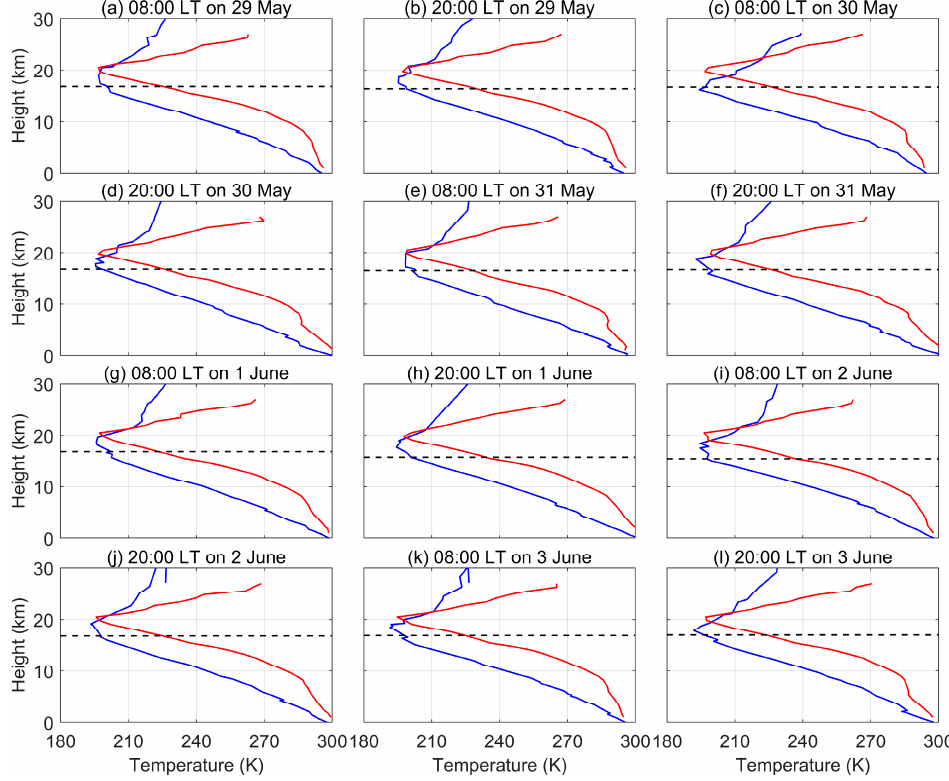
Figure 5. Temperature profiles over Wuhan provided by the radiosonde (blue curves) and by ERA5 (red curve) from 8:00 LT on 29 May to 20:00 LT on 3 June with 12 h steps. The horizontal dashed lines show the height of the tropopause estimated by the blue temperature profiles.